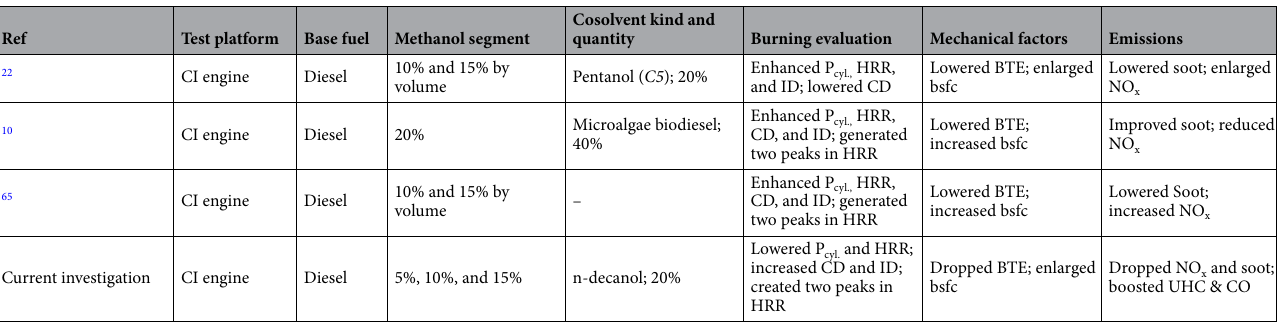
Table 5. Assessment of the existing research findings with available relevant